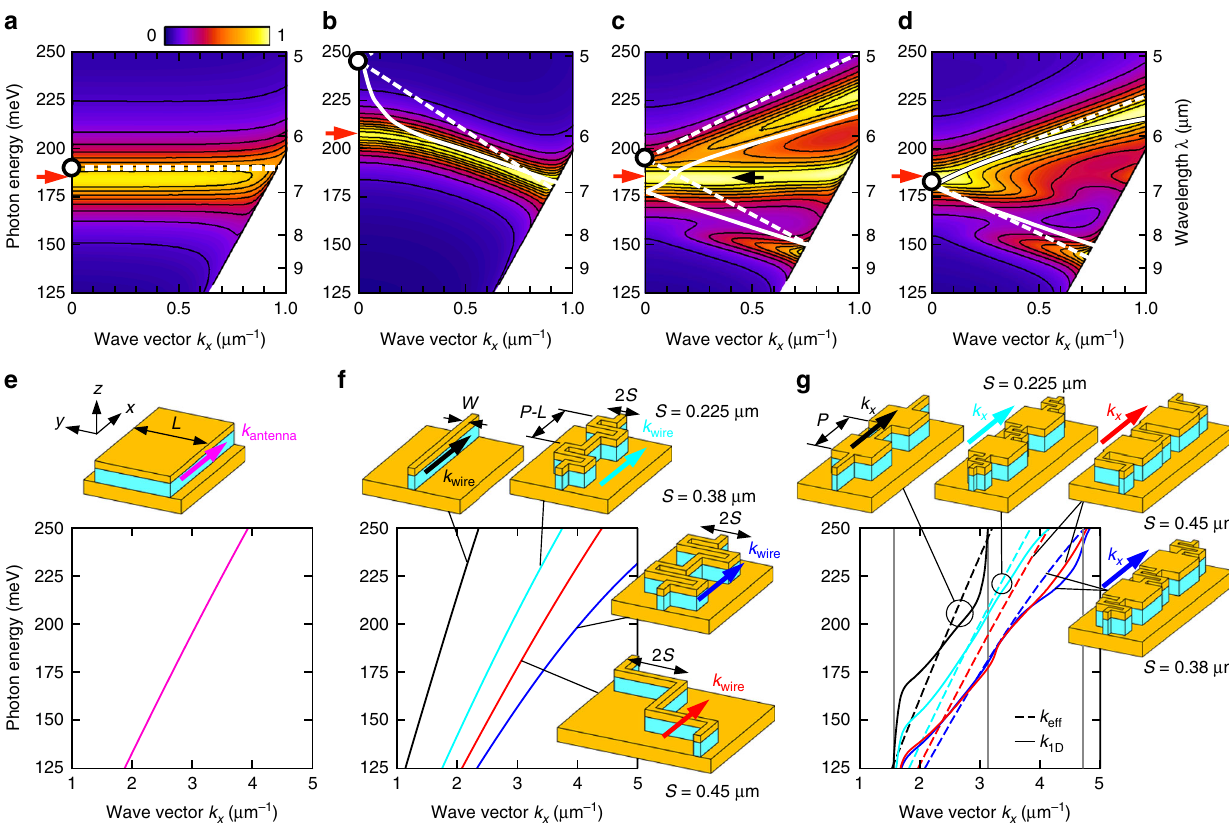
Fig. 4 Resonance engineering of arrayed antennas based on wire geometry. a – d Wave-vector dependence of absorption spectra for p -polarized incidence. a Array of isolated antennas. b Antennas connected with straight, c Z-shaped ( S = 0.45 μ m), and d S-shaped ( S = 0.38 μ m) wires. e – g Dispersion relation (real part) of TM-like propagation mode in elementary structures illustrated by the schematics. e MIM waveguide with width L . This dispersion gives the resonance of arrayed isolated antennas represented in a by a broken line. f In fi nitely repeated folded plasmonic wires. g 1D periodic system made of antennas and wires, k 1D (solid curves). The broken lines are k eff based on Eq. (2). The dispersions of wired antennas represented by solid and broken lines in g are also displayed by solid and broken lines in b – d . The vertical gray lines denote the BZ edges where bandgaps can